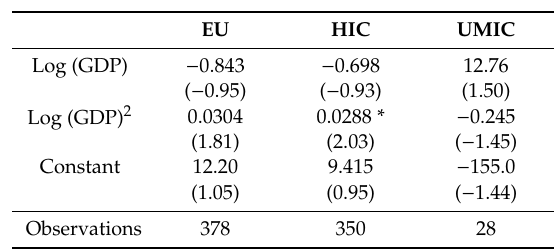
Table 3. Environmental Kuznets relationship.